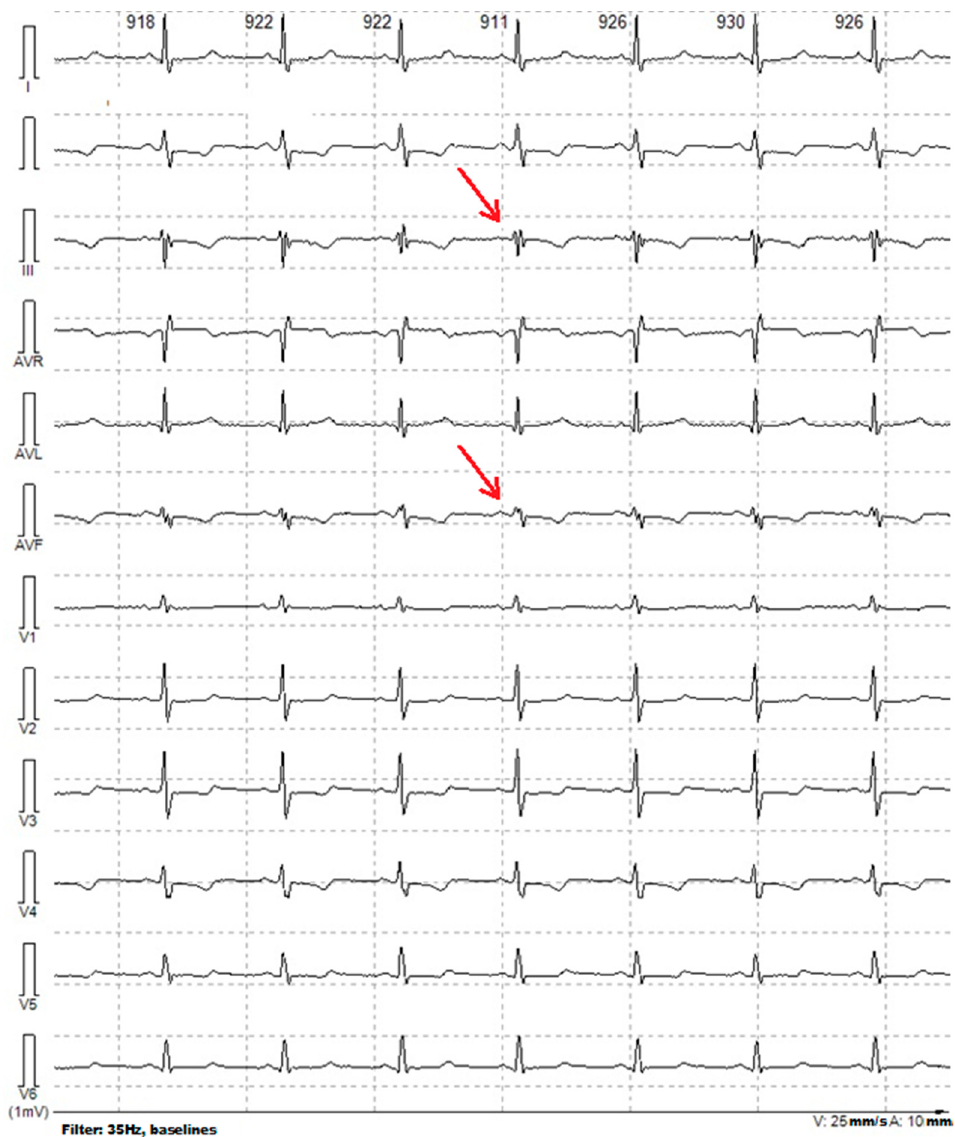
Figure 4. Example of ECG with fQRS in a female patient with mildly reduced ejection fraction of the left ventricular; FQRS in leads III and AVF, no pathological Q wave was registered, the QRS duration is normal; Arrows shows the fragmentation of the QRS.